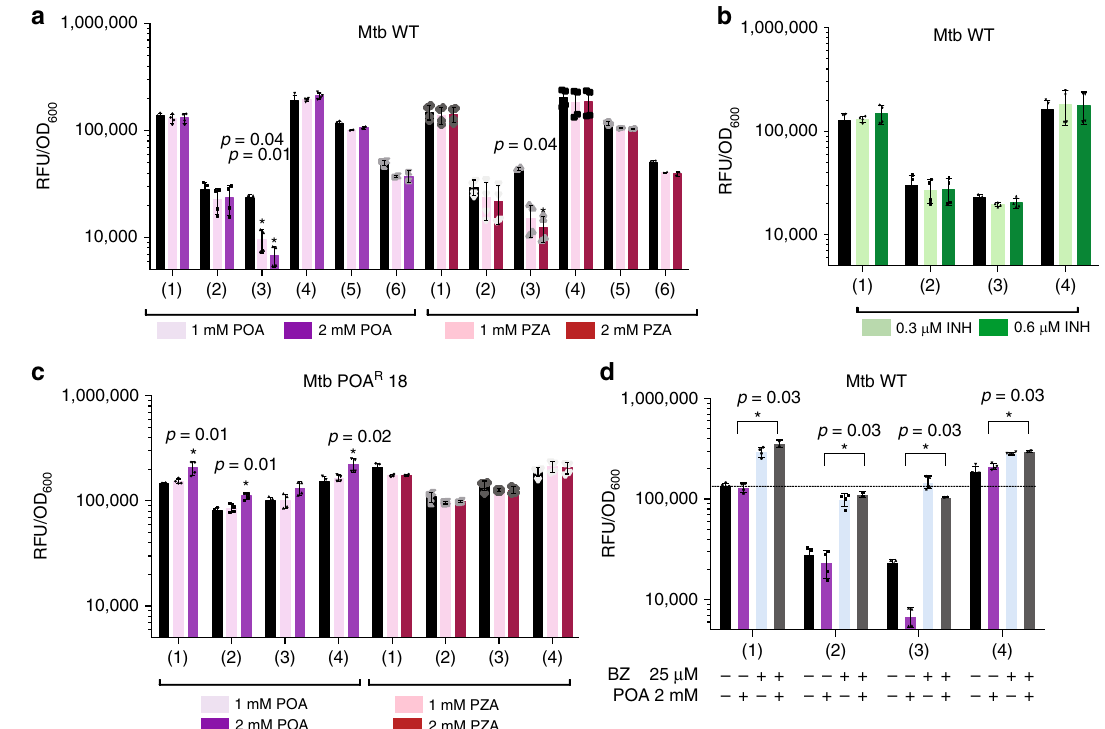
Fig. 3 Effect of POA, PZA, INH treatment, and POA/bortezomib co-treatment on levels of various RFP – PanD fusions. Mtb strains harboring various RFP – PanD fusions shown in Fig. 2a were treated with increasing doses of POA, bortezomib (BZ), and isoniazid as control drug (INH) for 3 days. Fluorescence (RFU) was measured and normalized to bacterial growth (OD 600 ). a RFP – PanD fusions in Mtb wild type (WT) treated with POA (1 mM or Mtb MIC 50 ) and PZA. b RFP – PanD fusions in Mtb wild type treated with isoniazid (INH): 0.3 µ M or Mtb MIC 50 . c RFP – PanD fusions in POA-resistant clpC1 mutant Mtb POA R 18 [ clpC1 : Lys209Glu] treated with POA and PZA. d RFP – PanD fusions in Mtb wild type treated with BZ (25 µ M or Mtb MIC 50 ) or POA (2 mM) alone or in combination as indicated. The dashed line indicates mean normalized culture fl uorescence of drug-free RFP controls. a – c One-way ANOVA multiple comparisons test (Dunn ’ s posttest, GraphPad Prism) was used to compare fl uorescence levels in drug-treated versus drug-free controls. * p value < 0.05. d The two-sided Mann – Whitney U test (GraphPad Prism) was used to compare the effect of POA treatment on fl uorescence levels conferred by RFP constructs 1 – 4 ( a wild-type background) in the presence and absence of BZ. * p value < 0.05. For each strain and treatment, drug-free controls were included (black bars). Experiments were repeated twice independently with two technical replicates. Error bars were de fi ned as standard deviations. Source data are provided as a Source Data fi